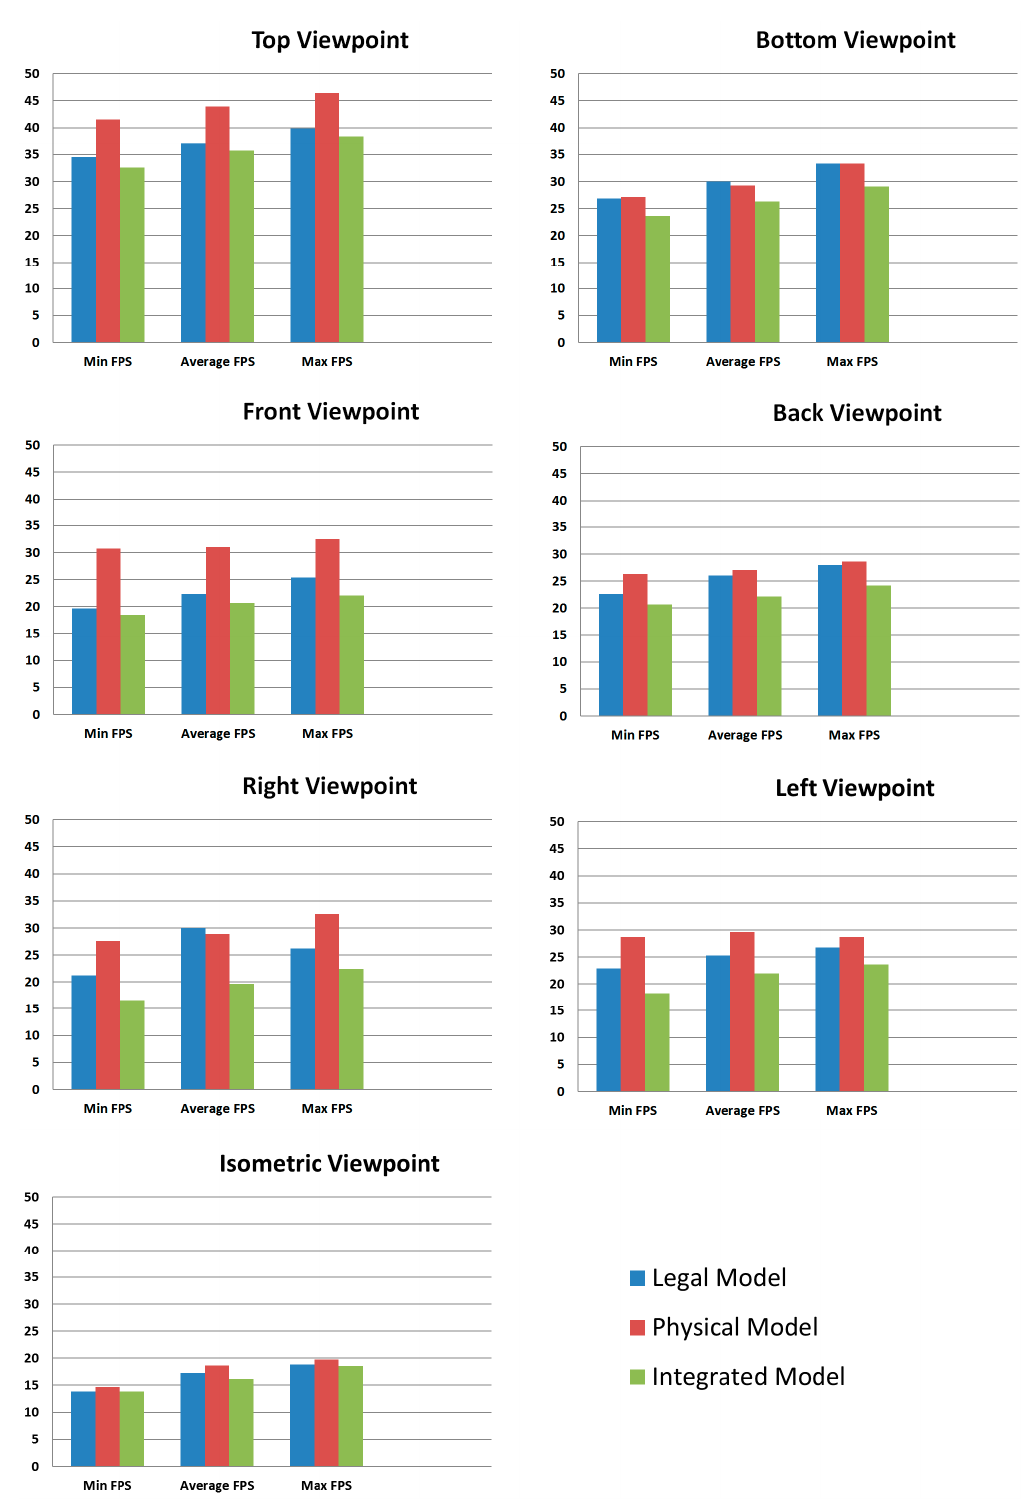
Figure 9. Minimum, maximum and average FPS for each model from various viewpoints in Solibri Model Viewer. Model